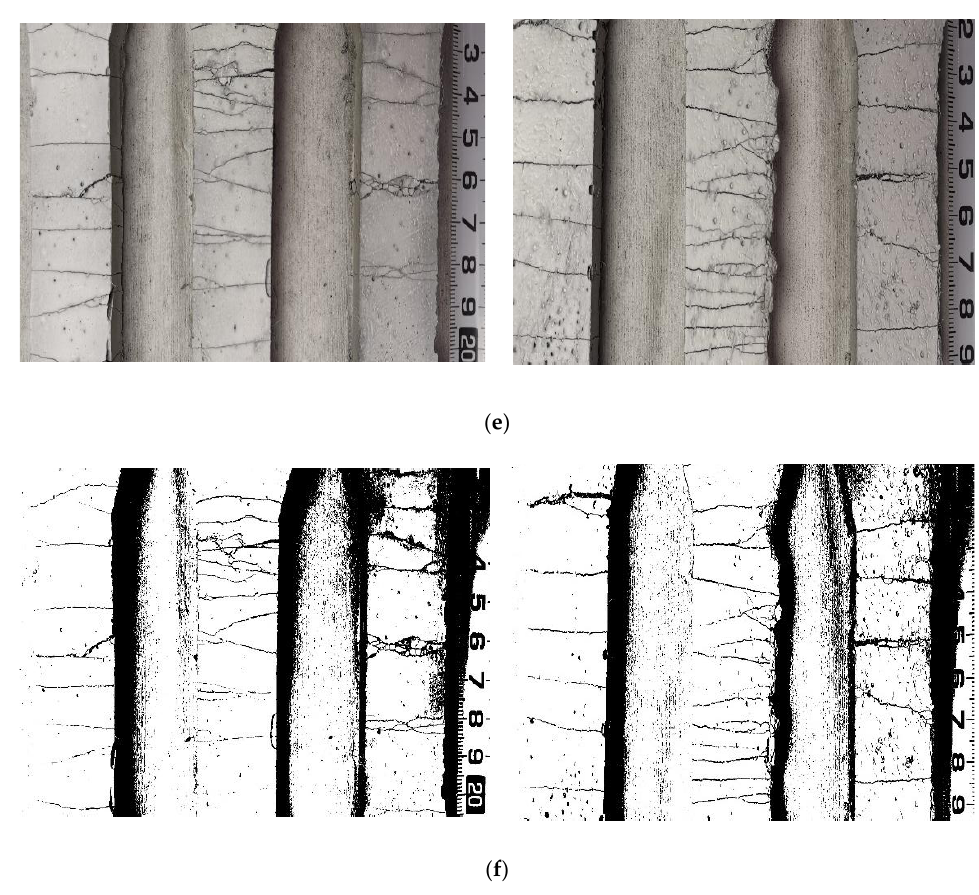
Figure 9. Damage pattern at 28 d in ( a ) (0%-Slag)/ SF-0-60, ( b ) (5%-Slag)/ SF-5-55, ( c ) (10%-Slag)/ SF-10-50, ( d ) (15%-Slag)/SF-15-45, and ( e , f ) corresponding a binary image of crack path.